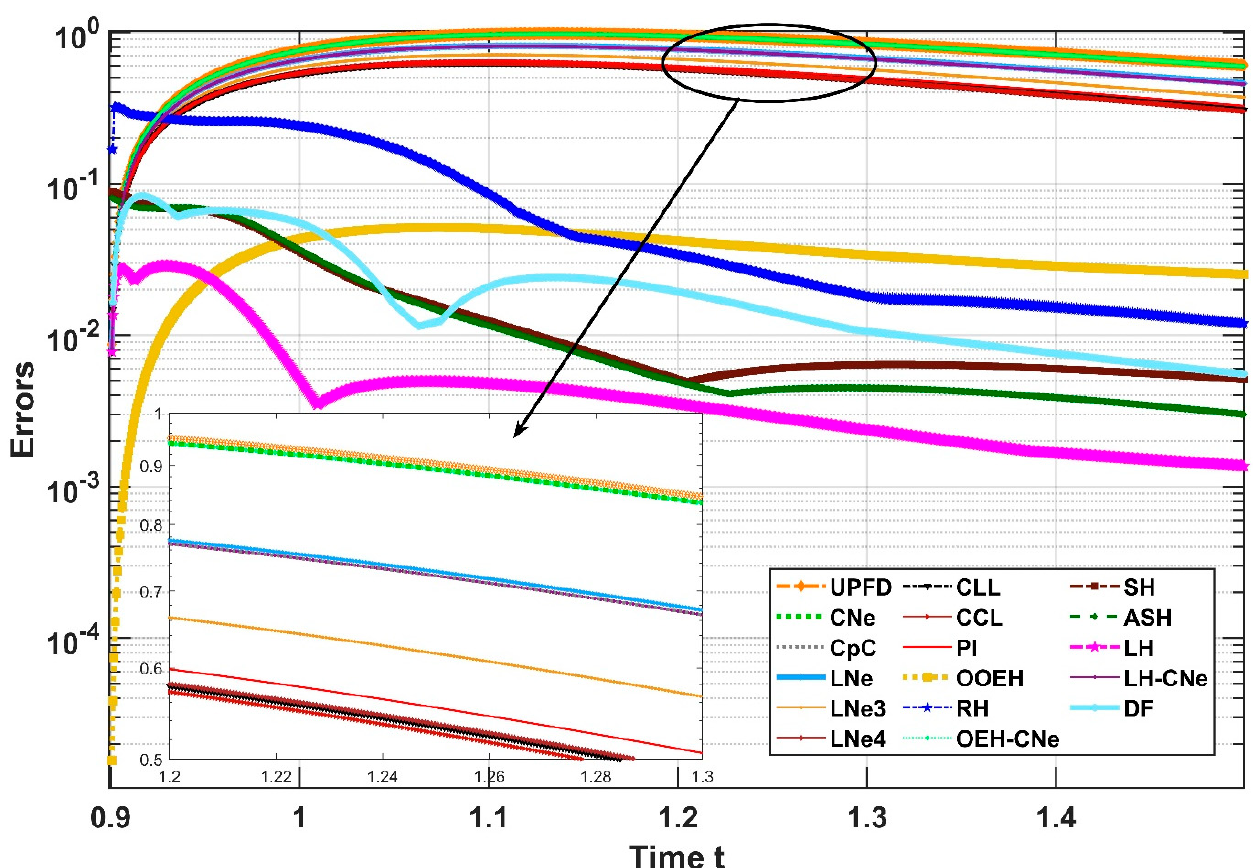
Figure 9. The variable u as a function of x in the case of the initial function u 0 , the analytical solution at the fi nal time, the CCL algorithm for ℎ = 1.2 ⋅ 10 (cid:2879)(cid:2873) , and the LH algorithm for ℎ = 0.0016 in the case of large value of m (Experiment 2).